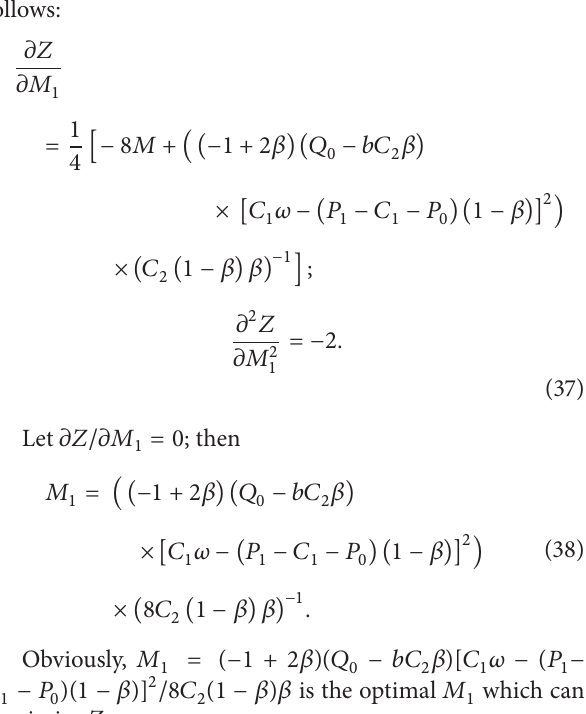
Figure 3: The change of the customer’s profit with 𝑡 , when 𝐶 2 = 1.5